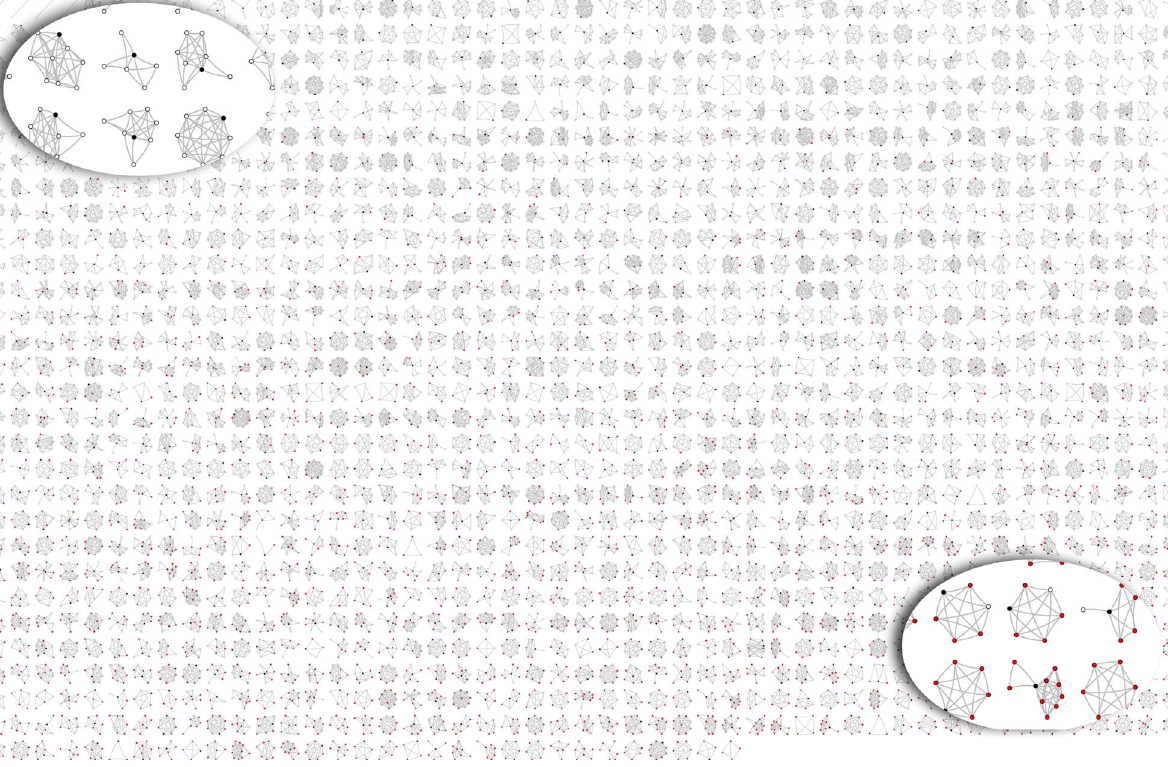
Fig. 3 Health habits in participants ’ personal social network. In each network, a black circle is the participant, a white circle is a healthy social contact, and a red dot is an unhealthy social contact. Unhealthiness is de fi ned as someone who does any of the following: smokes, does not exercise, does not visit doctors regularly, or not compliant with prescription medications. Networks are arranged from least negative health in fl uence (top left) to most negative health in fl uence (bottom right)